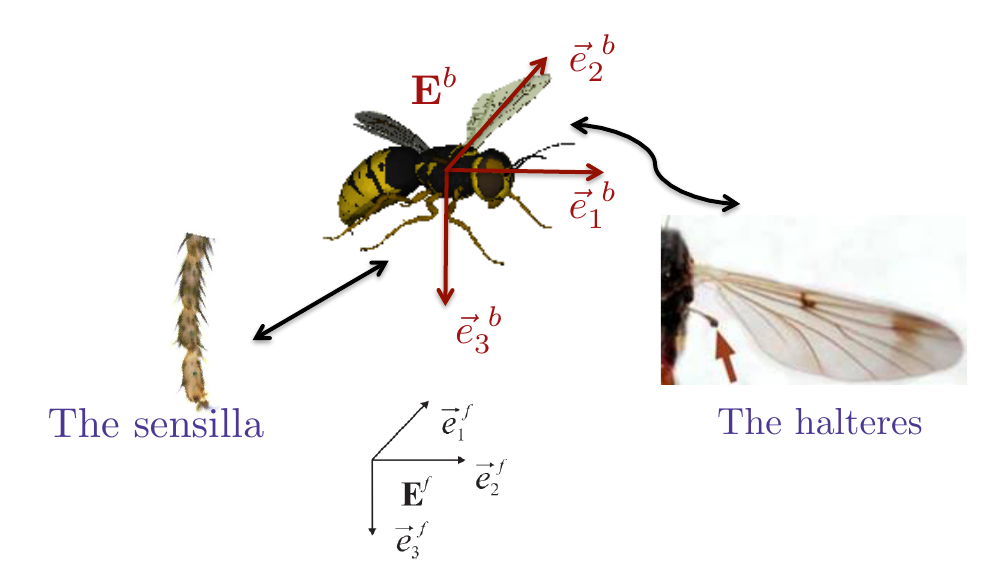
Figure 2. Biologically-inspired attitude